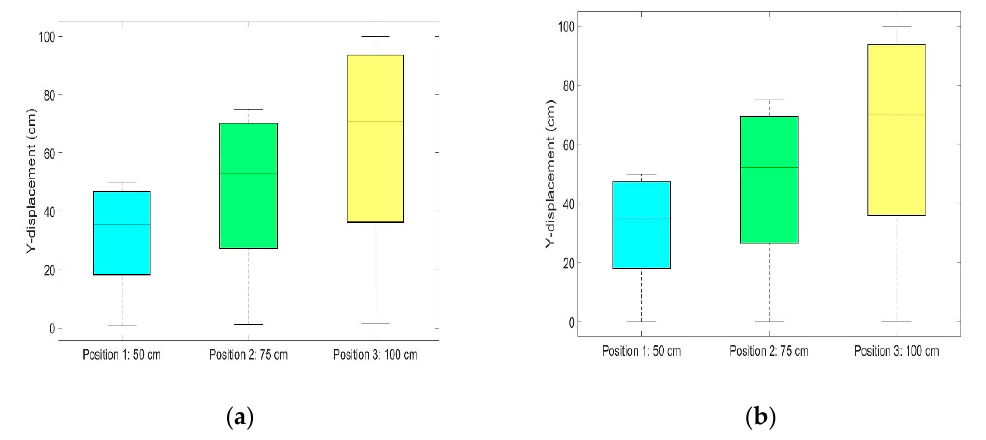
Figure 8. Box plots for (a) manual, (b) accelerometry-based measurements.